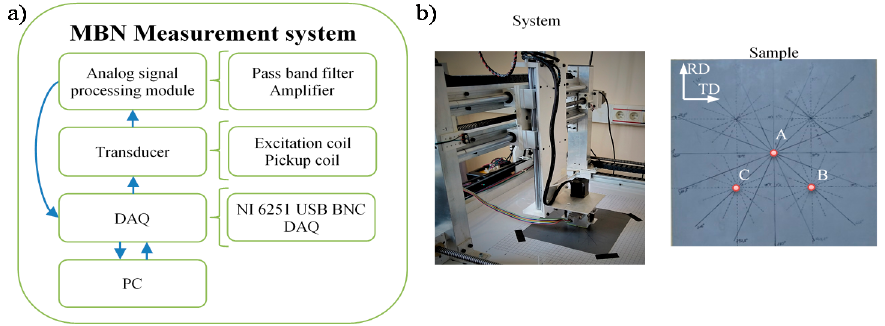
Figure 1. Magnetic Barkhausen noise (MBN) measurement system: ( a ) block diagram, ( b ) photo of the setup and sample.